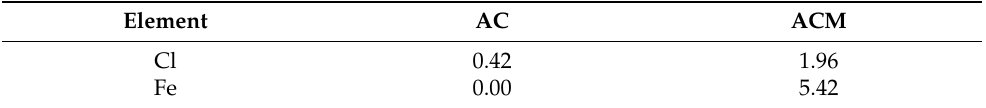
Figure 8. Mapping of elements present on the surface of the activated carbon modified with 5.0 wt.% of magnetite nanoparticles (ACM) sample by SEM-EDX analysis. Table 2. Compositional analysis EDX of the activated carbon modified with 5.0 wt.% of magnetite nanoparticles (ACM) and without nanoparticles (AC).